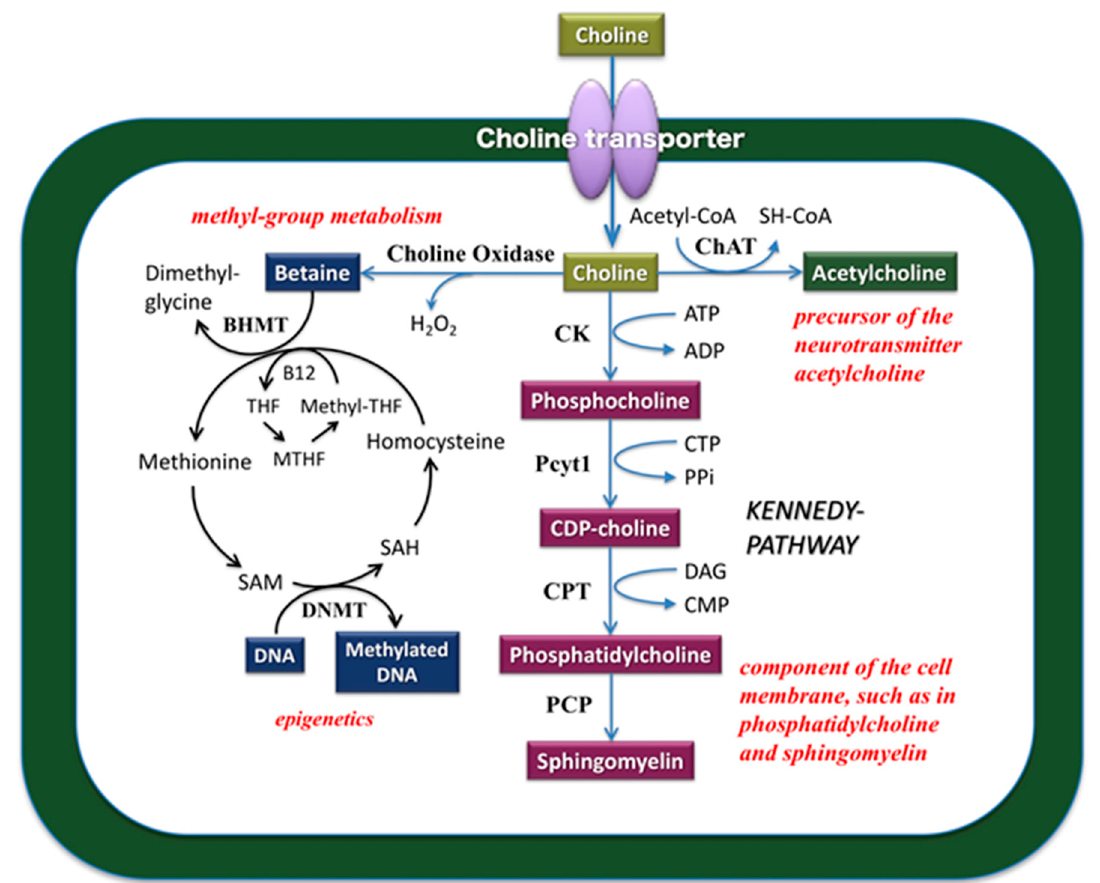
Figure 2. Choline metabolic pathway. Choline is an essential biological molecule for all cells and is required forthesynthesisofphosphatidylcholineandsphingomyelin, whicharethemajorcomponentsoftheplasma membrane. New cell membrane synthesis requires the rate-limiting step of choline uptake, followed by phospholipidbiosynthesis. Cholineisalsoaprecursorfortheneurotransmitteracetylcholineandthemethyl donorbetaine,whichareinvolvedinseveralimportantbiologicalfunctions. Betaine,anoxidizedmetabolite of choline, is a source of methyl groups for the production of S-adenosylmethionine (SAM), which serves as a substrate for DNA and histone methyltransferases, and is thus required for the establishment and maintenance of the epigenome. Epigenetic mechanisms play important roles in biology and human diseases. ADP, adenosine diphosphate; ATP, adenosine triphosphate; BHMT,